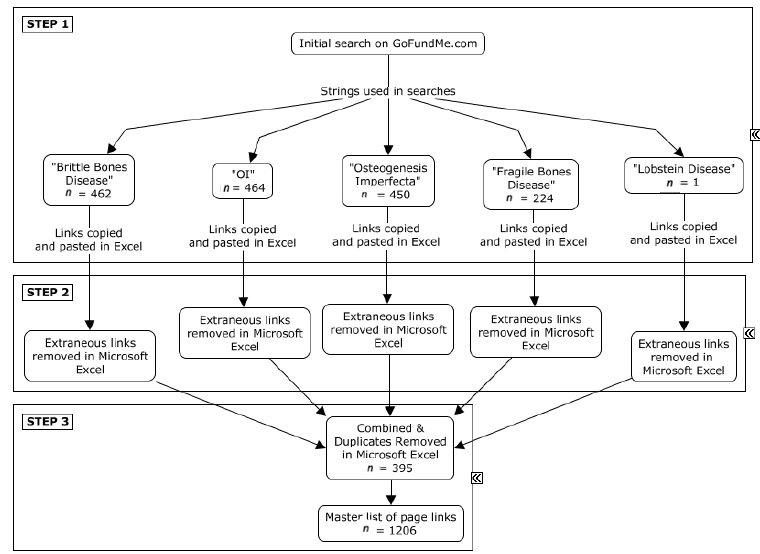
Figure 2. Flow diagram for Steps 1–3 of data collection method.